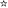
NLRP3 overexpression in microglia partially reversed the protective effect of Gen. (A) The representative apoptosis cytometry analysis of HT22 in N9 microglia–HT22–coculture system after OGD/R. (B) The apoptosis analysis of HT22 in different groups at 12 h after OGD/R. (C) The cell viability of HT22 in different groups at 12 h after OGD/R. (D) The release of lactate dehydrogenase (LDH) in different groups at 12 h after OGD/R. (E) The release of inflammatory factors at 12 h after OGD/R. Data are presented as the mean ± SD and analyzed by the Kruskal–Wallis test followed by Dunn test. *P < 0.05 compared to the sham group, P < 0.05 compared to OGD group, #P < 0.05 compared to Gen group, &P < 0.05 compared to Gen + NLRP3 group, n = 4 per group.